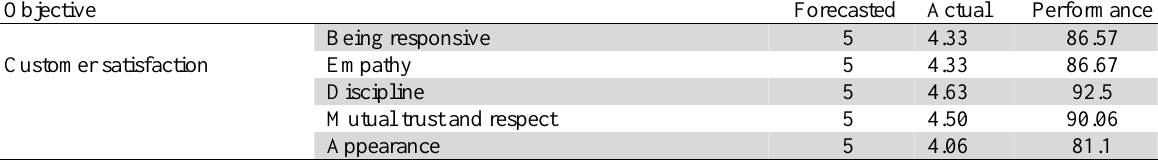
Table 4 The results of forecasted and actual numbers for customer perspective